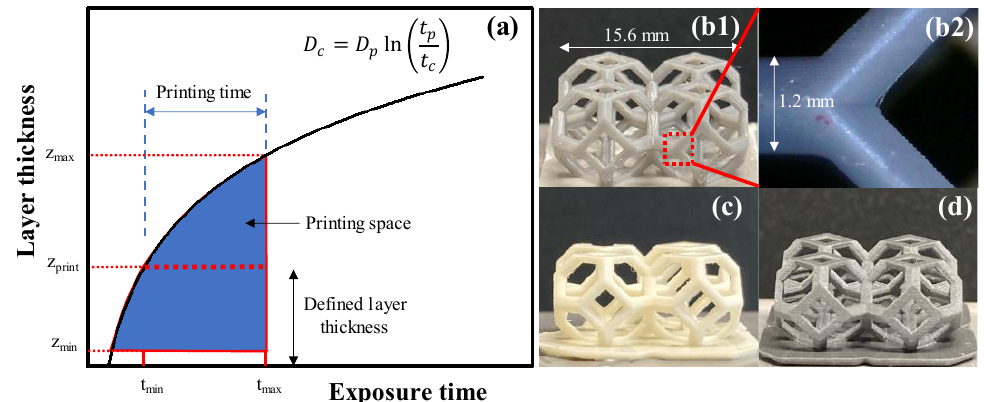
Figure 7. Schematic of DLP printing map defining optimized printing space ( a ). Objects printed with G-Strong ( b1 ), ( b2 ) Porcelite ( c ), and Ferrolite ( d ) resin using the parameters from the map.